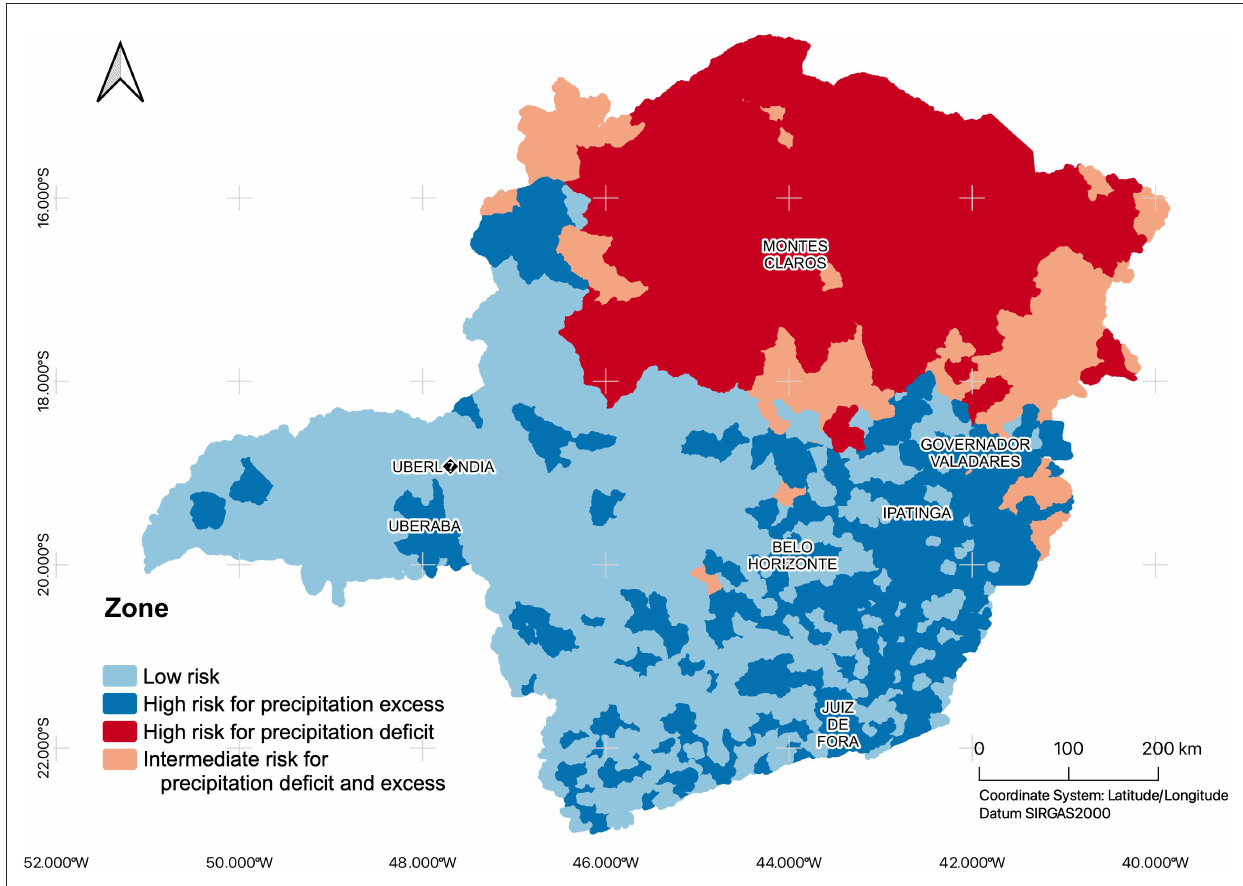
FIGURE3 Precipitation-related disaster zones in Minas Gerais, Brazil. Source: Anderson et al. (2013), Instituto Brasileiro de Geografia e Estatística – IBGE (2020), and The Climdex Project—Xavier et al. (2015).